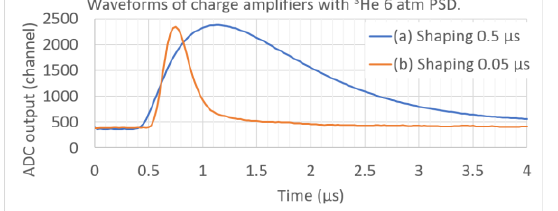
Fig. 9. Pulse shaping time constants of (a) 0.5 µs and (b) 0.05 µs .